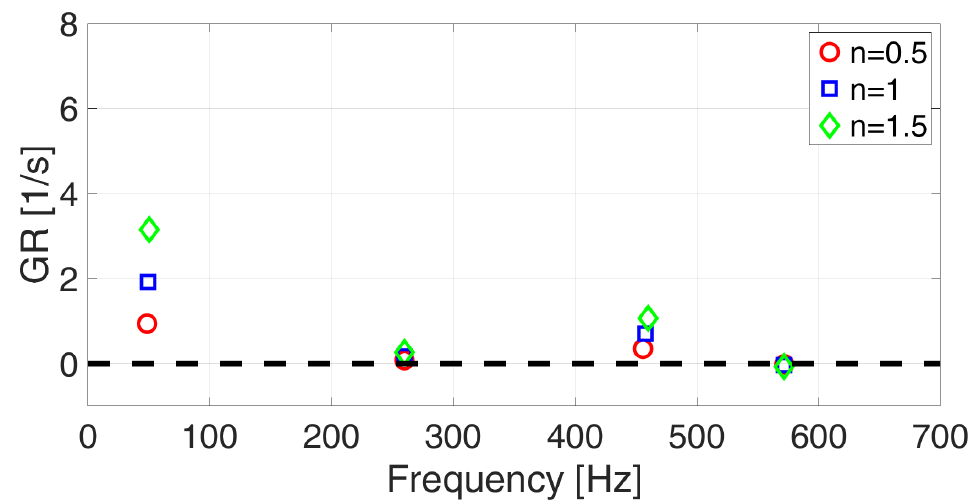
Figure 17. Sensibility analysis on the interaction index n for the benchmark CH 4 –air mixture.